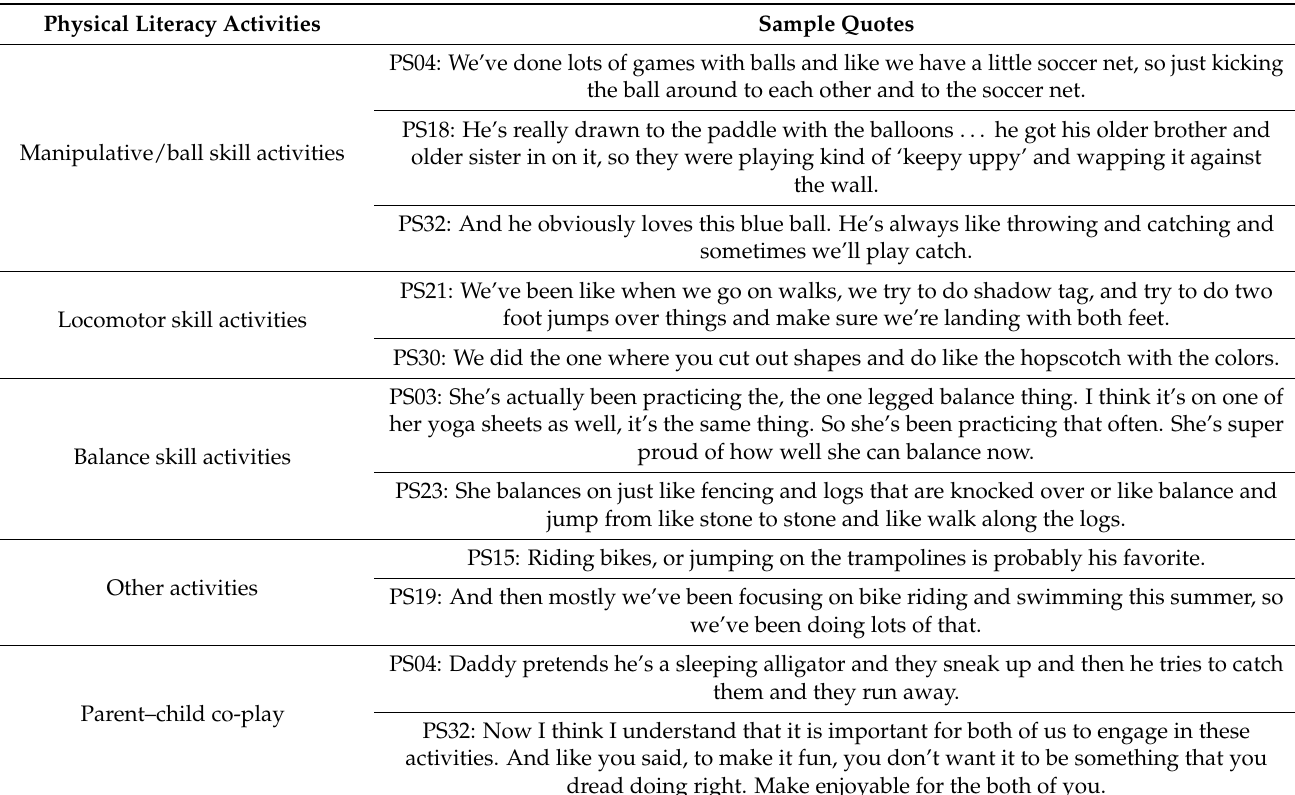
Table 2. Physical literacy activities performed since the virtual workshop, with sample